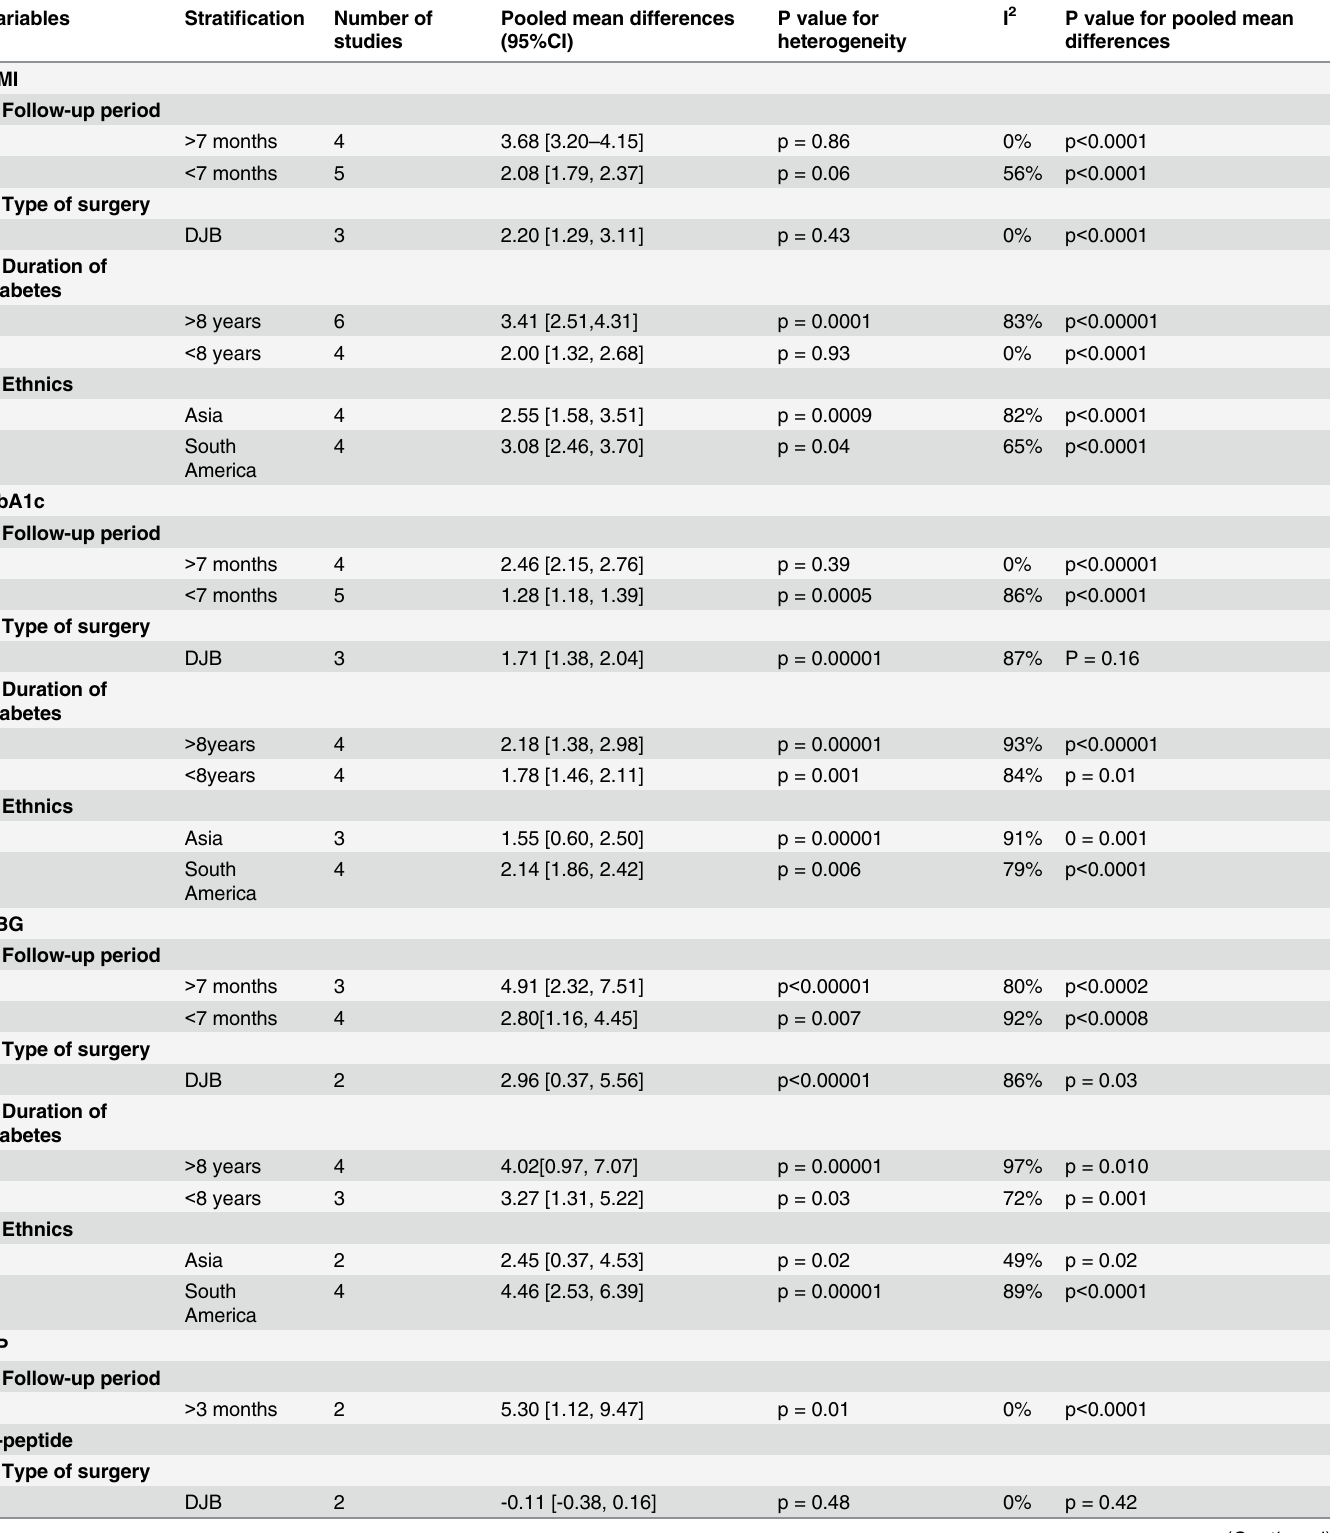
Table 2. Stratified analyses of the investigated